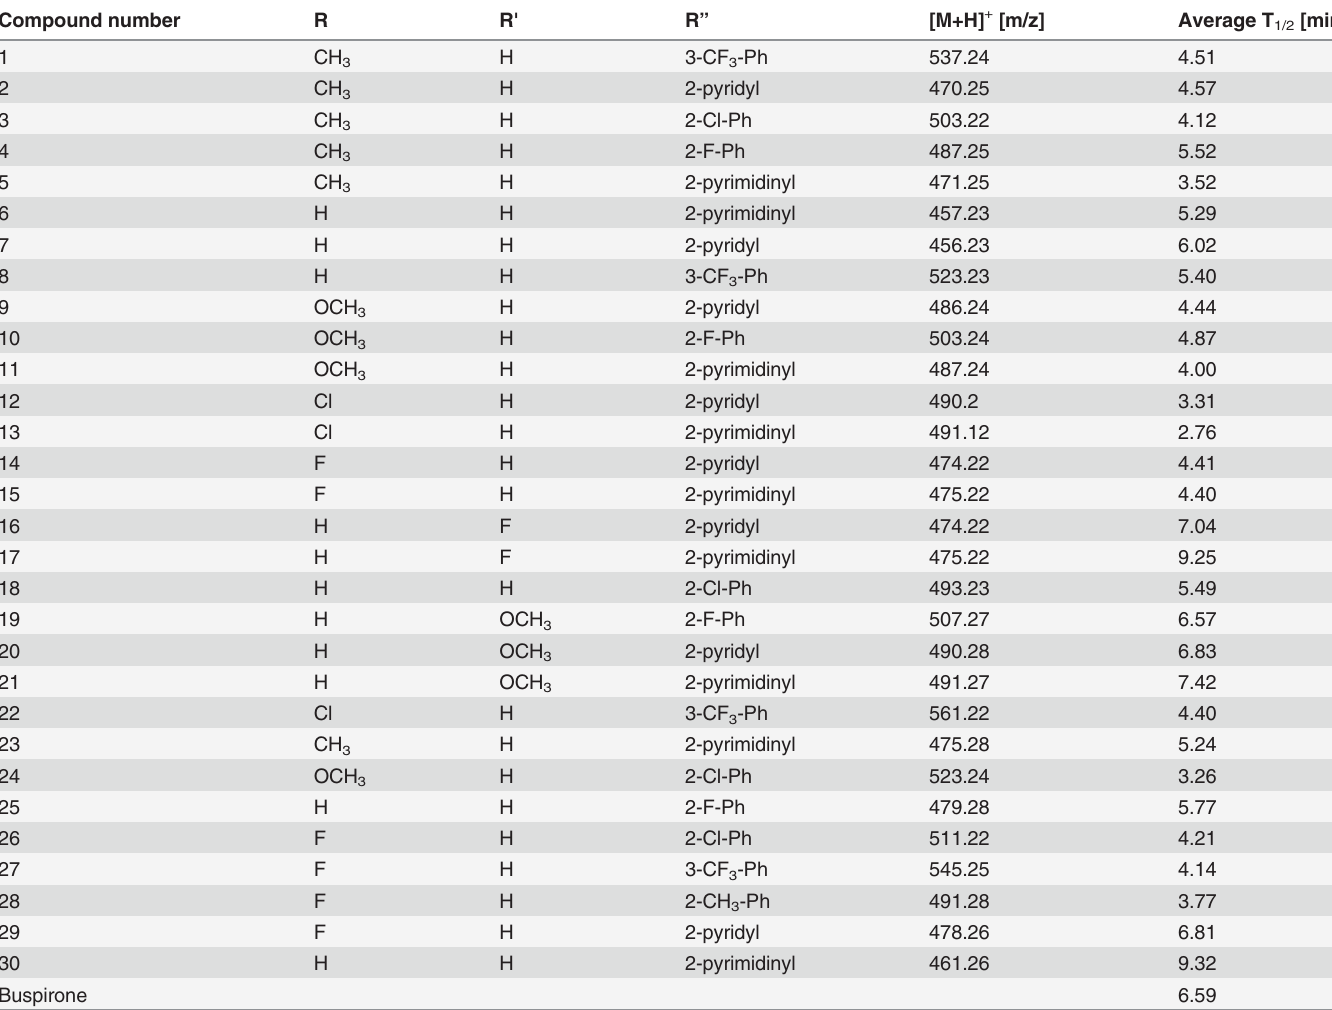
Table 1. Compound moieties, pseudo-molecular ion masses and values for estimated